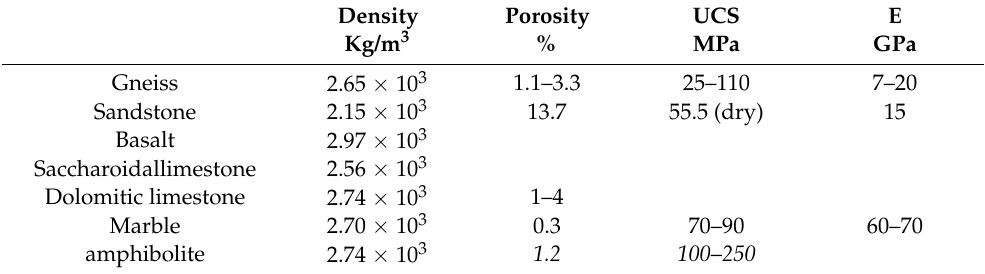
Table 1. Mechanical and physical properties of rock types (values in italics come from